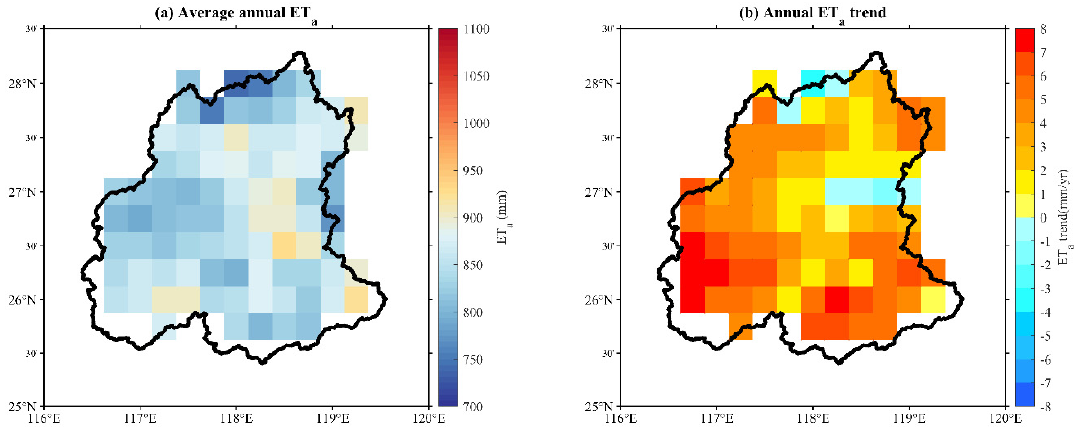
Figure 4. Average annual ET a ( a ) and its trends ( b ) in the MRB from 2000 to 2019, and grid at 0.25° × 0.25°. The black dots in Figure 3b indicate that the variation rates passing the significance test (M-K trend test) at the 0.05 confidence level.